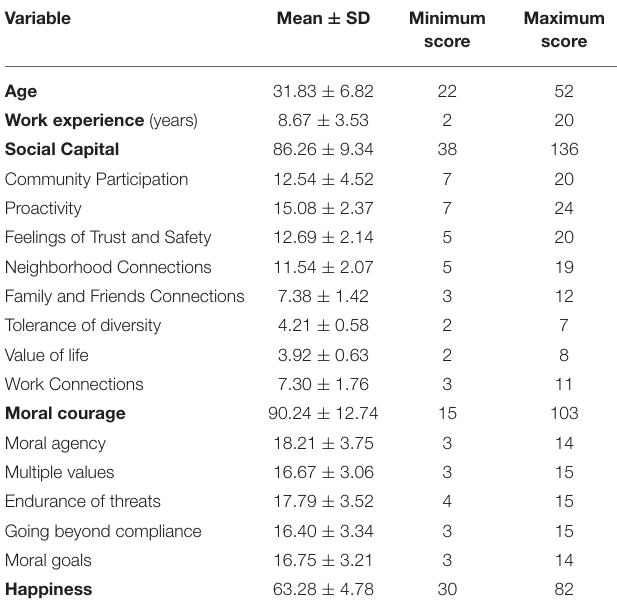
TABLE 1 | Descriptive statistics of the research